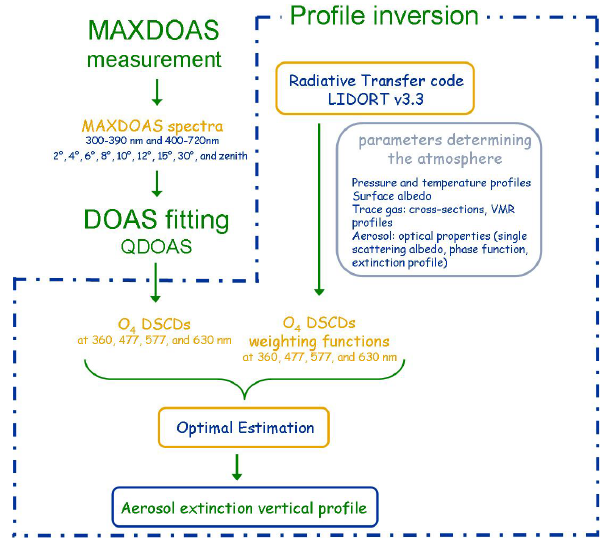
Fig. 5. Flow chart for the aerosol extinction profile retrieval